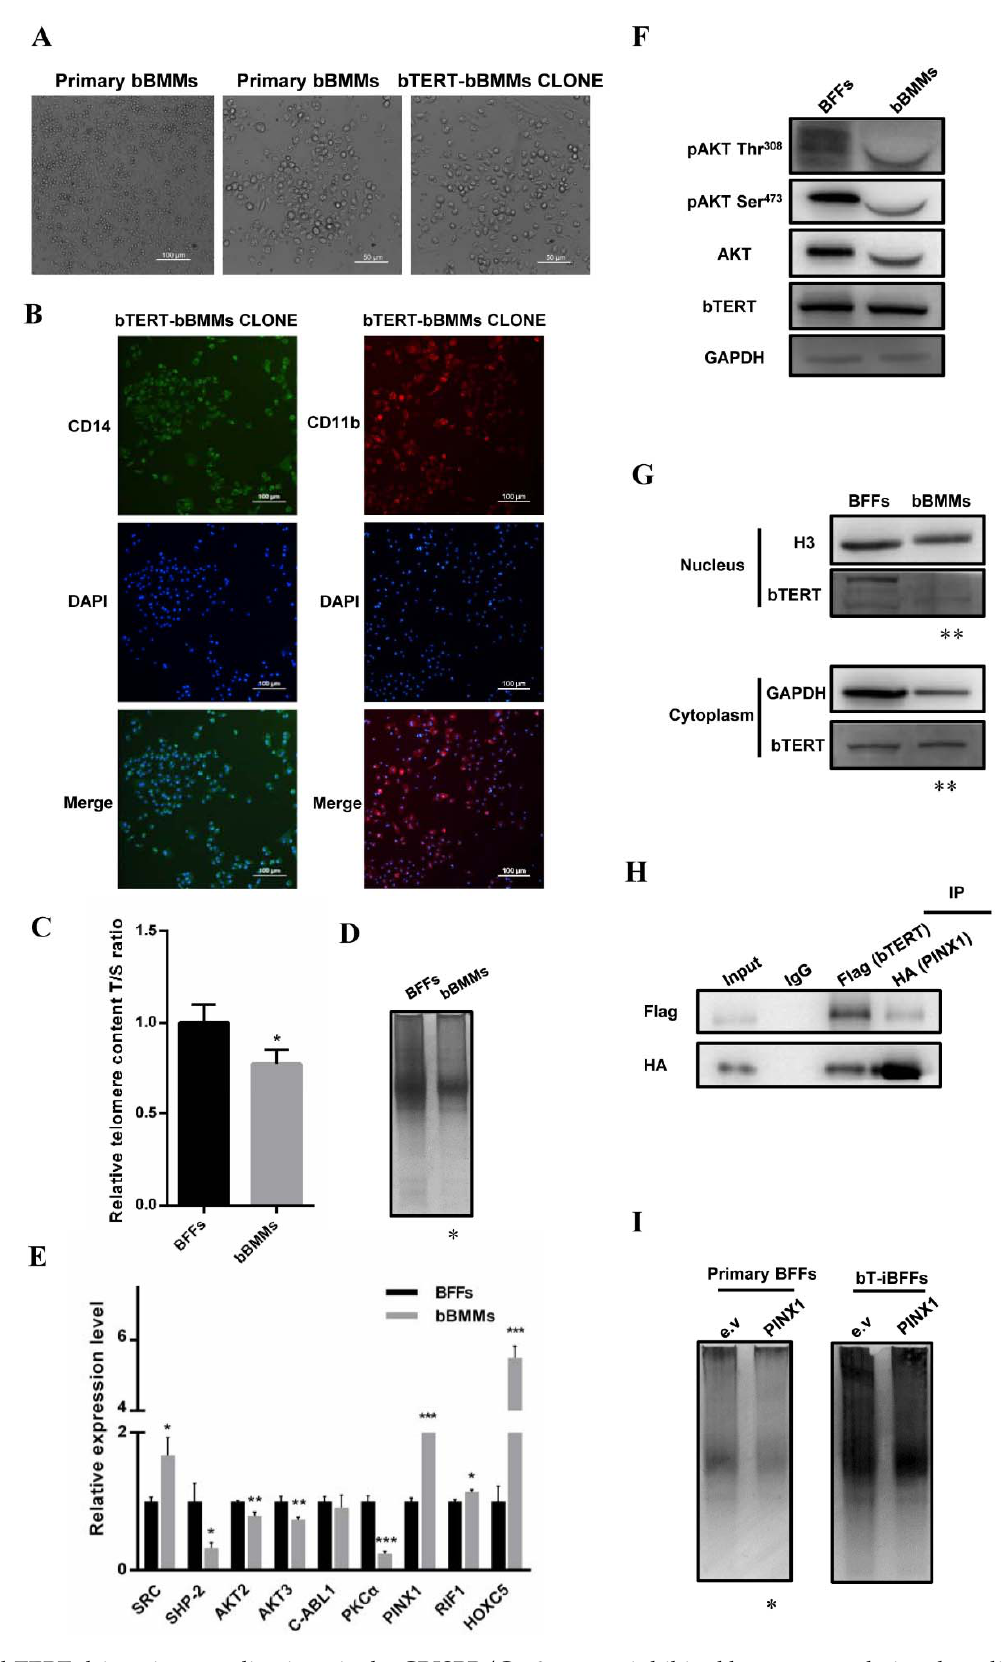
Figure 4. bTERT ‐ driven immortalization via the CRISPR/Cas9 system inhibited by post ‐ translational modification in Figure 4. bTERT-driven immortalization via the CRISPR/Cas9 system inhibited by post-translational modification in bBMMs. ( A ) Cellular morphology of bBMMs (scale bar = 100 μ m/50 μ m) and b TERT ‐ bBMM colony (scale bar = 50 μ m). bBMMs. ( A ) Cellular morphology of bBMMs (scale bar = 100 µ m/50 µ m) and b TERT -bBMM colony (scale bar = 50 µ ( B ) The expression of macrophage markers CD14 and CD11b in b TERT ‐ bBMM colony detected by immunofluorescence.